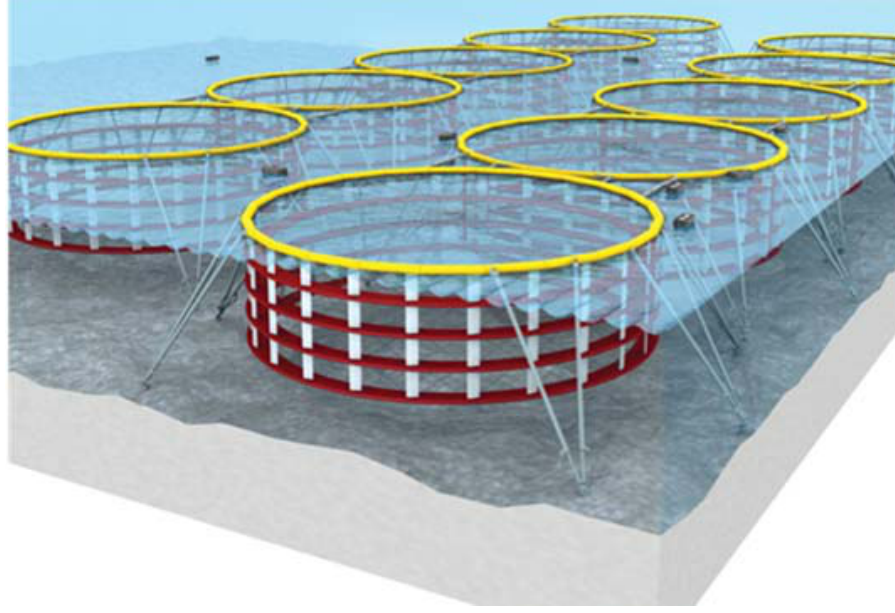
Figure 1. Artist’s impression of close ‐ packed vertical ‐ axis contra ‐ rotating rotors [12].